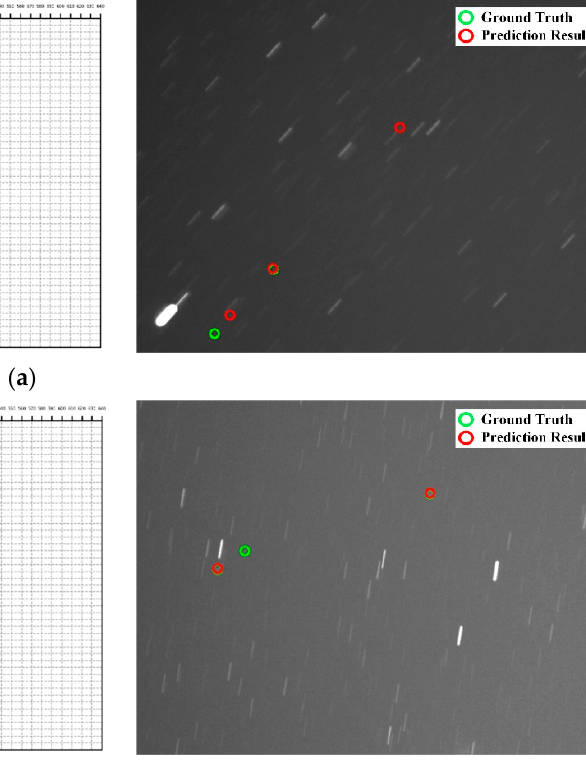
Figure 9. Performance of the proposed multi-frame space object detection method on the test set: ( a – c ) show the space targets that can be detected correctly in different spatial distribution within one sequence. The prediction results of PP-YOLOv2 detector are marked by the green solid circle; the final results after the post-process procedure of CFS are marked by the red cross symbols. Additionally, the blue cross symbols indicate the ground truth.